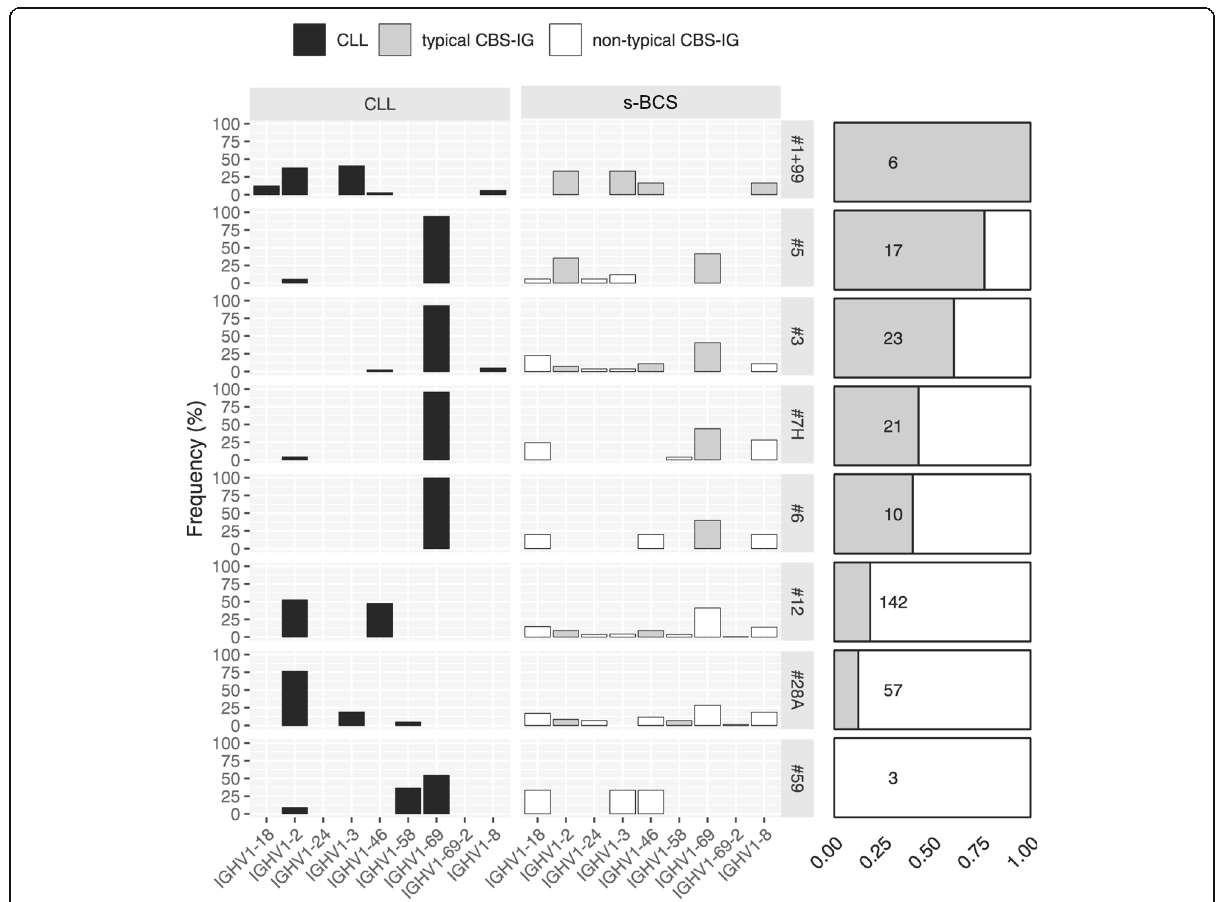
Fig. 2 Utilization of IGHV1 family genes by CBS-IG and by CLL stereotype rearrangements. Normal (s-BCS) CBS-IG rearrangements are classified as typical (grey) or non-typical (white) based upon whether the IGHV1 genes utilized were the same or different from those commonly used by CLL clones for a given rearrangement (black). The relative frequency of typical and non-typical CBS-IG in s-BCS (considered in bulk) for each stereotype subset is reported on the right of the figure. Numbers in boxes indicate the total number of sequences investigated for each